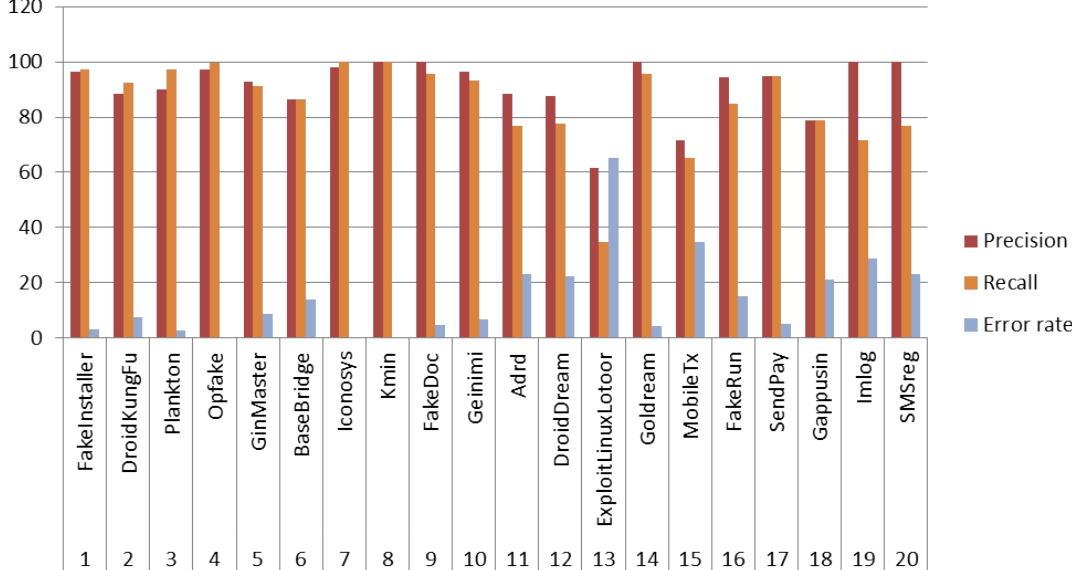
Figure 9. Precision, Recall, and Error rate of CNN-SVM in top 20 malware families of Drebin Dataset.